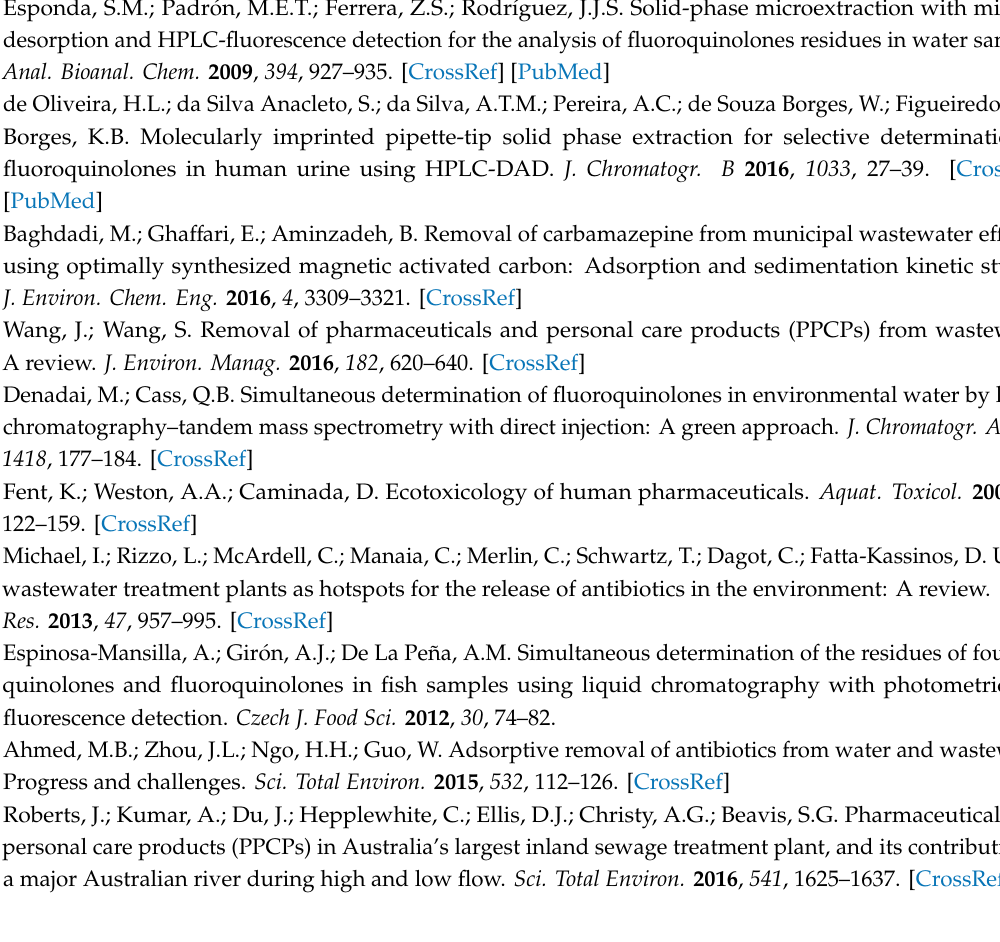
Figure A5. Intraparticle diffusion model.